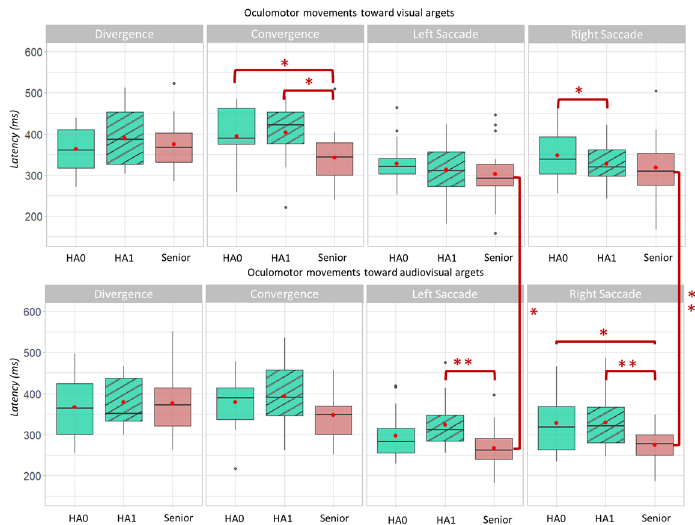
Figure 4. Oculomotor latencies as a function of eye movement, groups (HA0 represents group Senior_HA when participants are not wearing their hearing aids, HA1 represents group Senior_HA when participants were wearing their hearing aids, Senior represents participants in group Senior), and target sensory modality. Figures in the upper part represent eye movements to visual targets, figures in the lower part represent eye movements to audiovisual targets. Asterisks indicate Wilcoxon test p values less than 0.05: ‘*’ for 0.01 < p < 0.05; ‘**’ for 0.001 < p <